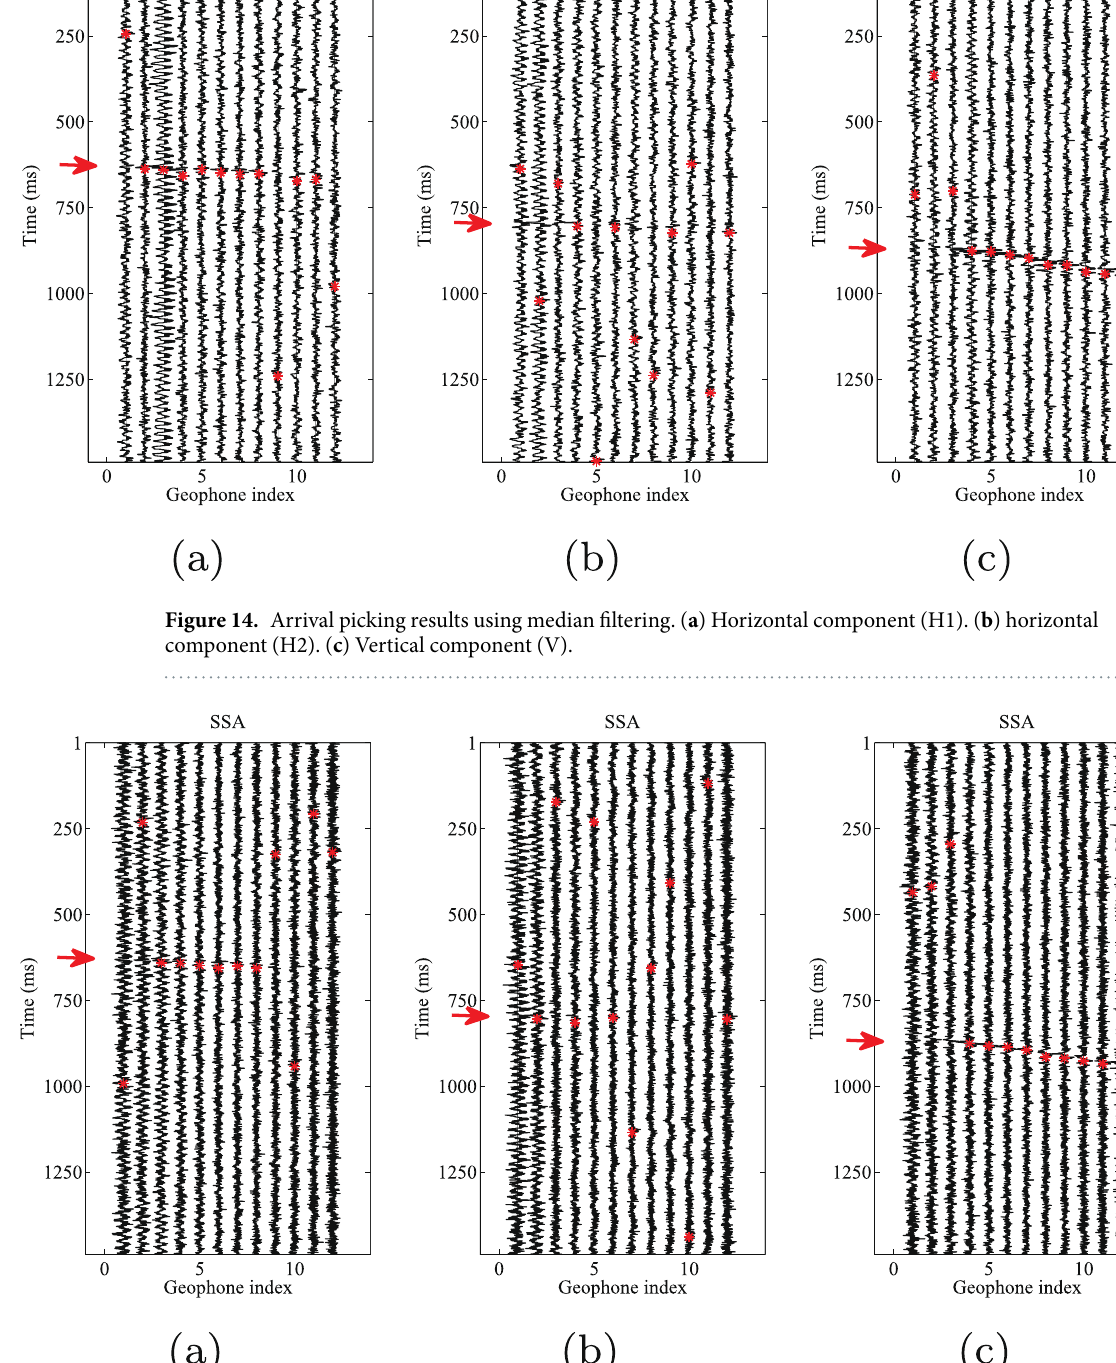
Table 1. Comparison of events detection in recorded data and denoised data after using different denoising